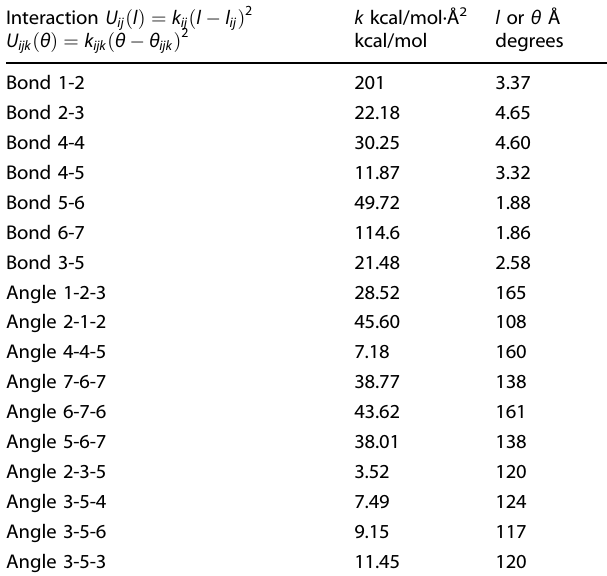
Table 1. List of all the bonded interaction parameters of the CG model obtained from Boltzmann inversion of the distributions of bonds and angles in the AA simulations, calculated between the centers of mass of the corresponding CG